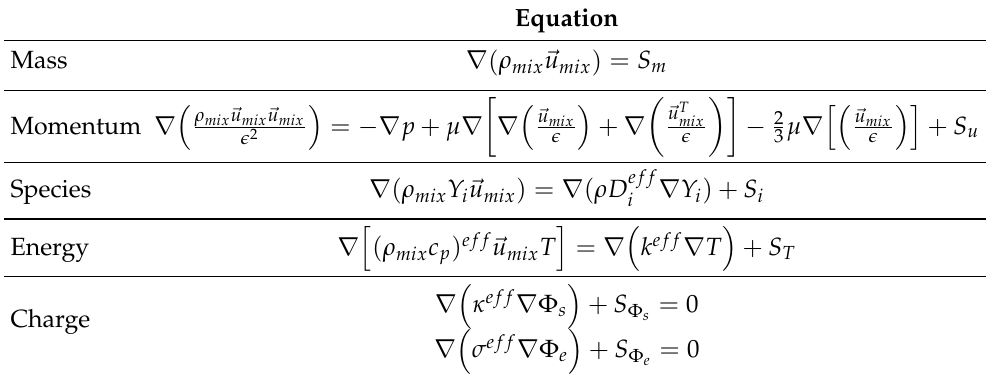
Table 1. Steady-state form of the mixture multi-phase (MMP) governing equations from [5,24].